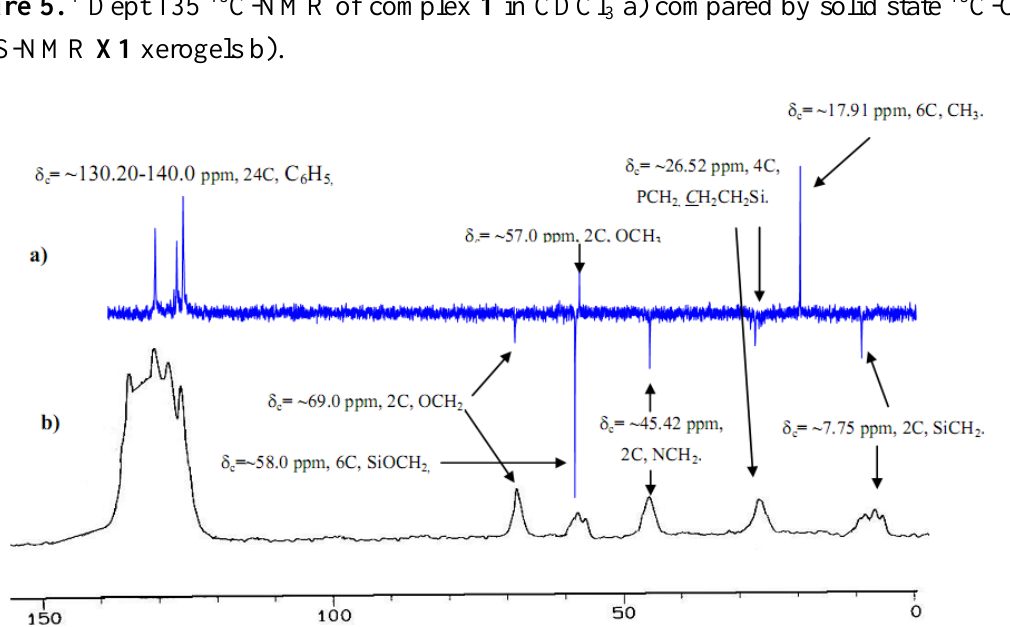
a) compared by solid state 13 C-CP- 3